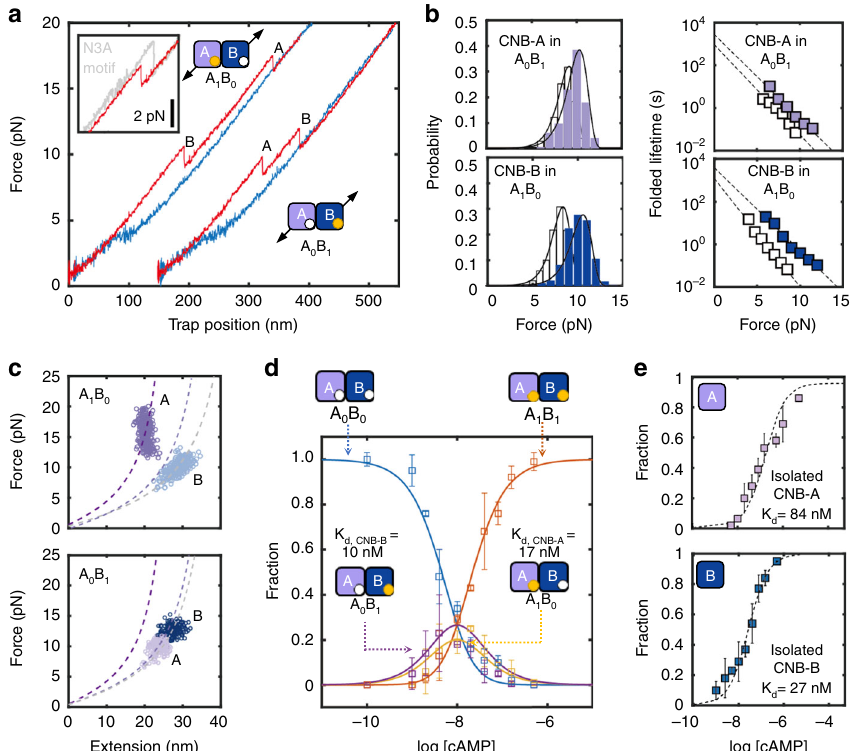
Fig. 5 Stepwise stabilization between CNB domains in partial cAMP-bound states. a Representative force-extension curves of two intermediate-liganded states (A 1 B 0 and A 0 B 1 ) for the type-III regulatory subunit S110C/S376C. Zoomed-in are the unfolding trajectories of A 1 B 0 compared with fully bound state (i.e., A 1 B 1 ), showing the lack of N3A motif hopping in A 1 B 0 . b Unfolding force probability distribution and force-dependent folded-state lifetimes for intermediate-liganded states: CNB-A domain in A 0 B 1 (top) and CNB-B domain in A 1 B 0 (bottom). The corresponding isolated domains in the apo state (white bars and symbols) are shown for comparison. Solid lines are the unfolding force distribution reconstructed from force-dependent lifetimes. c WLC analysis of changes in extension upon unfolding vs. force in A 1 B 0 and A 0 B 1 for the CNB-A and CNB-B domains (dashed lines). Expected WLC curves are shown for CNB-A domain without the N3A motif (dark purple) and with the N3A motif (light purple). d cAMP titration plot showing the fraction of apo (A 0 B 0 ), intermediate (A 1 B 0 or A 0 B 1 ), and fully bound (A 1 B 1 ) species. Lines correspond to the global fi t to the equations for each population species (Supplementary Methods). Error bars are the weighted SD of different single molecules. e Fractional titration plot of isolated CNB-A (top) and CNB-B (bottom) domains (type-I constructs). The error bar corresponds to the SD of fi ve to ten different